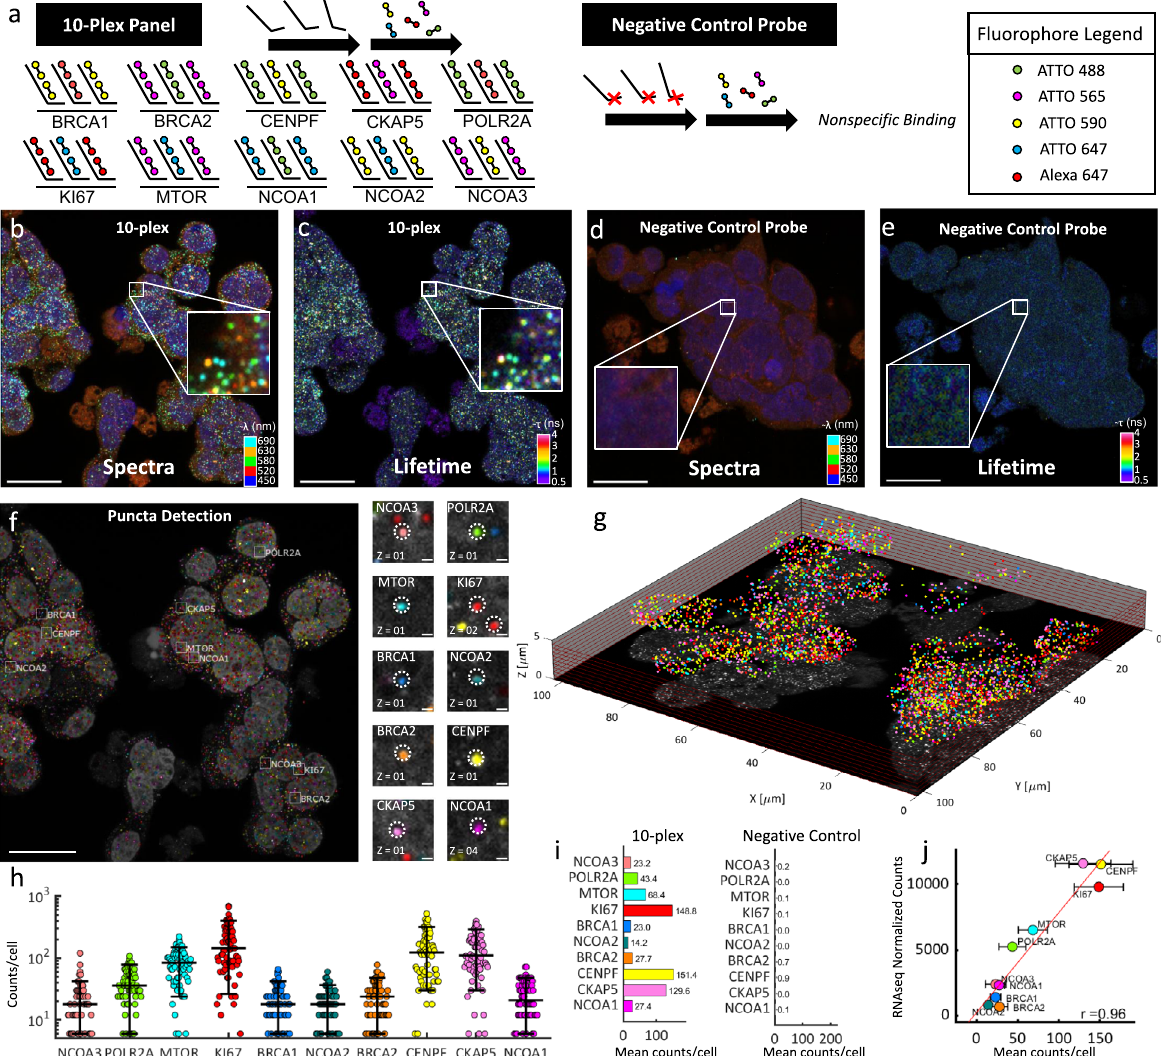
Fig. 4 Simultaneous 10-plex detection of transcripts for genes in colorectal cancer SW480 cells in a single round of labeling and imaging. a 10 different gene transcripts are labeled with primary probes followed by respective and complementary fl uorescent secondary probes. Each transcript is labeled with a combination of 2 out of 5 fl uorophores for 10 combinations. Negative control probes (mNeonGreen, DCT, TYRP1, and PAX3) targeting transcripts not present in the sample were used with their respective secondary fl uorophore probes. b Spectral image (max-projection in z) of a fi eld of view of the labeled 10-plex sample (5-channel pseudo coloring). c Lifetime image (max-projection in z) of a fi eld of view of the labeled 10-plex sample (phasor projection